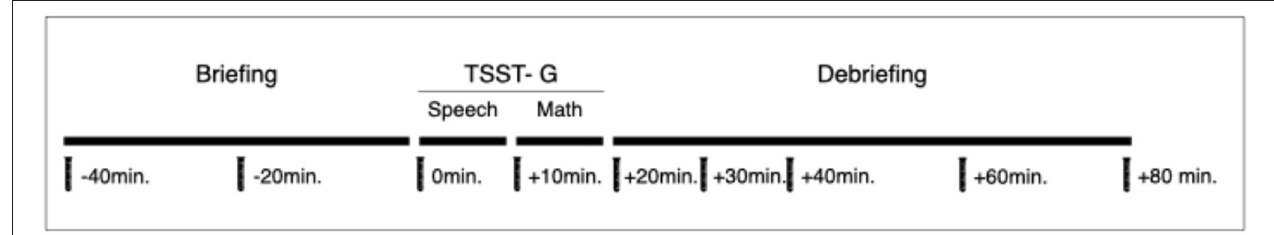
FIGURE 3 | Outline for the Trier Social Stress Test (for Groups). Physiological parameters are continuously monitored. At each time point, a psychological stress response assessment takes place and a saliva cortisol sample is collected.